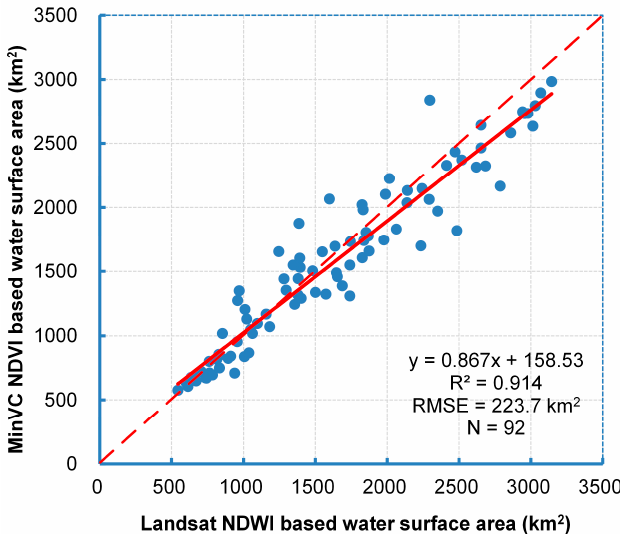
Figure 5. Comparison of the MinVC NDVI based and the Landsat NDWI based water surface area data (2003–2016).